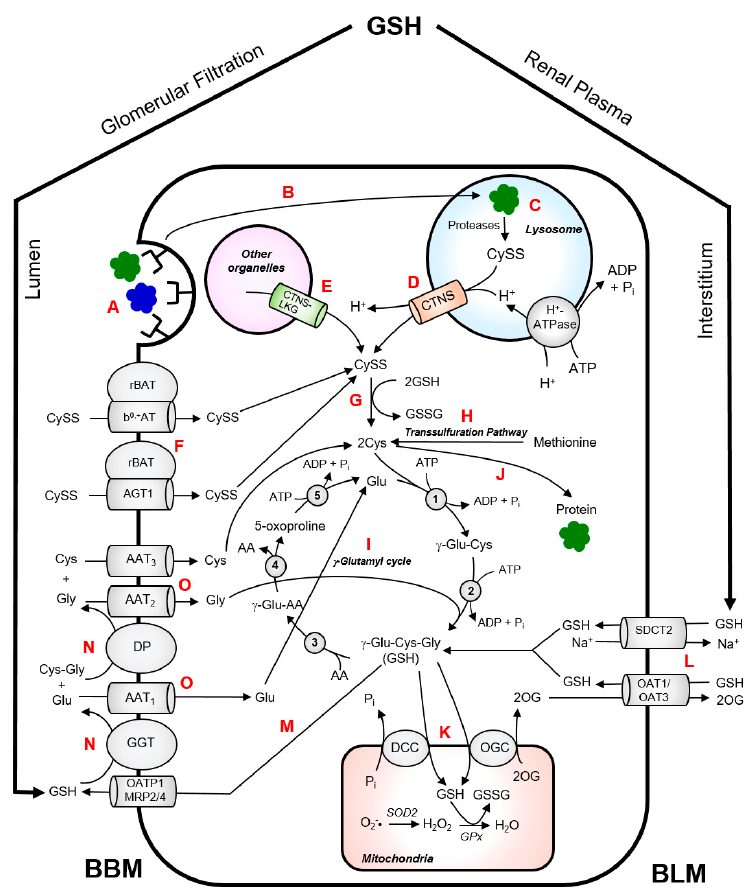
Figure 2. Intermediary thiol metabolism in renal proximal tubular cells. CySS-containing proteins are reabsorbed from the brushborder membrane (BBM) of the PTCs via receptor-mediated endocytosis (A). The CySS-containing proteins enter the lysosomal compartment via fusion of protein-loaded transport vesicles with the lysosomes (B). These proteins undergo cathepsin-catalyzed degradation which generates CySS (C). Cystinosin facilitates the proton-driven efflux of CySS from the lysosomes into the cytosol (D). Cystinosin-LKG can also facilitate exodus of CySS from other cytosolic compartments (E). Non-protein CySS can be taken up by PTCs through heterodimeric CySS transporters, b 0,+ AT-rBAT and AGT1rBAT, and contributes to the cytosolic CySS pool (F). In the cytosol, CySS is rapidly reduced to Cys by cytosolic reducing systems (G). Alternatively, Cys can also be produced via trans-sulfuration pathway (H). The Cys generated in the cytosol can be used for the synthesis of GSH via γ -glutamyl cycle (I) or synthesis intracellular proteins (J). Most of the GSH in the mitochondrial matrix is obtained from the cytosolic GSH pool via oxoglutarate carrier (OGC) or dicarboxylate carrier (DCC) (K). In the mitochondria, superoxide radicals (O 2 − • ) generated from oxidative phosphorylation are converted to hydrogen peroxide (H 2 O 2 ) by superoxide dismutase 2 (SOD2). H 2 O 2 is eventually neutralized to water (H 2 O) by glutathione peroxidase (GPx) which requires GSH as a cofactor. The kidney extracts approximately 80% of GSH from the plasma. Approximately 50% of this GSH enters the PTCs via sodium–dicarboxylate cotransporter 2 (SDCT2) and organic anion transporters 1 and 3 (OAT1/3) at the BLM (L). Glomerular filtration accounts for approximately 30% of the GSH extraction via BBM route. GSH can also undergo turnover by efflux into the lumen via either organic anion transporting polypeptide 1 (OATP1) or multidrug resistance proteins 2 and 4 (MRP2/4) (M). The high activity of γ -glutamyltransferase (GGT) and dipeptidase (DP) in the BBM of PTC facilitates degradation of GSH to its constituent amino acids (N). The constituent amino acids are then taken up by their respective transporters (AAT) (O) and are used for the cytosolic re-synthesis of GSH. Enzymes of the γ -glutamyl cycle: γ -glutamylcysteine synthetase (1); GSH synthase (2); γ -glutamyl transpeptidase (3); γ -glutamyl cyclotransferase (4); 5-oxoprolinase